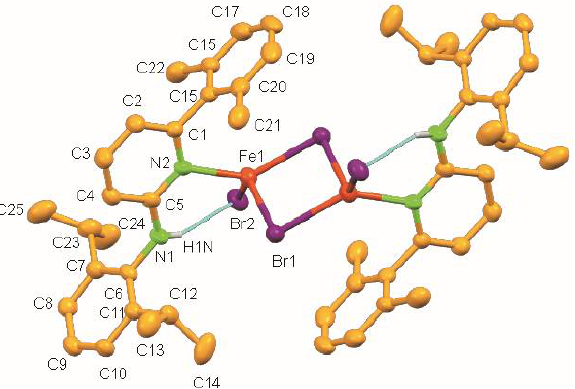
Figure 2. Molecular structure of 1 . Ellipsoids are set at 50 % probability; hydrogen atoms except N-H are omitted for clarity. Table 2. Selected bond lengths (Å) and angles (°) of structures 1 and 2 .